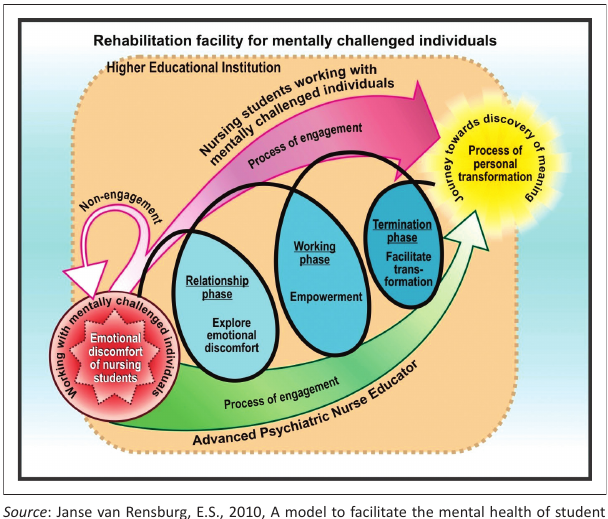
FIGURE 1: Janse van Rensburg’s conceptual framework (2010) to facilitate the mental health of student nurses working with persons with intellectual